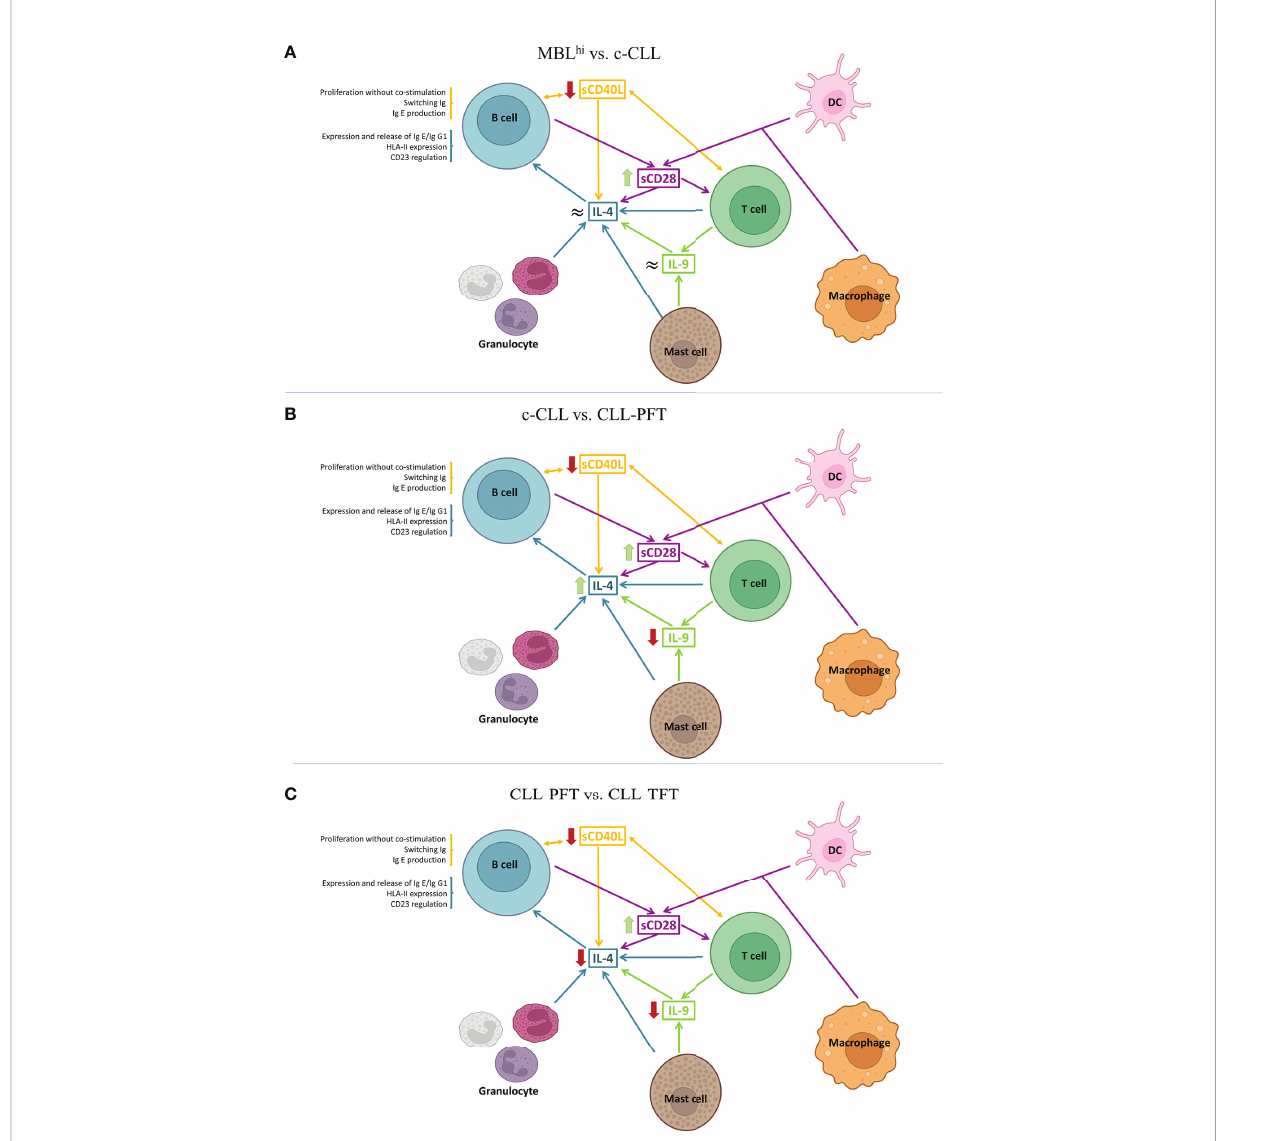
FIGURE 5 Schematic models of the TME from the role of the observed differential serum pro fi les. (A) MBLhi vs. c-CLL (stable and progression). (B) c-CLL vs. CLL-PFT. (C) CLL-PFT vs. CLL-TFT. (Created in